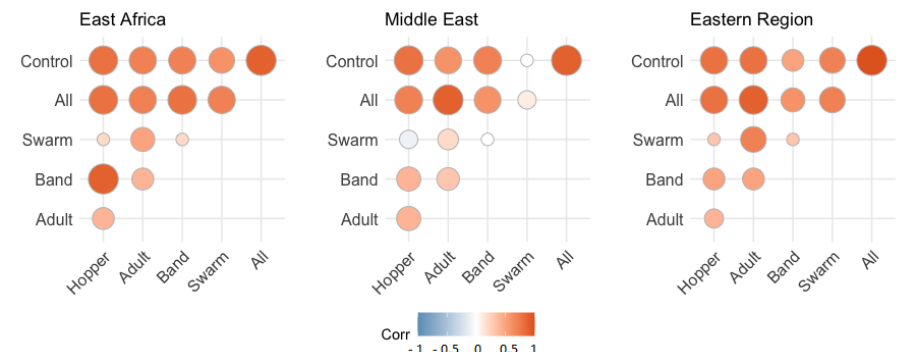
Figure 3. Correlation matrices between the weekly number of control operations and desert locust reports. Colour intensity and the size of the circle are proportional to the correlation coefficients. Data from [24] (Locust